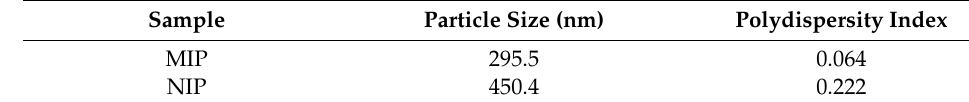
Table 1. Particle size and polydispersity index of MIP and NIP.